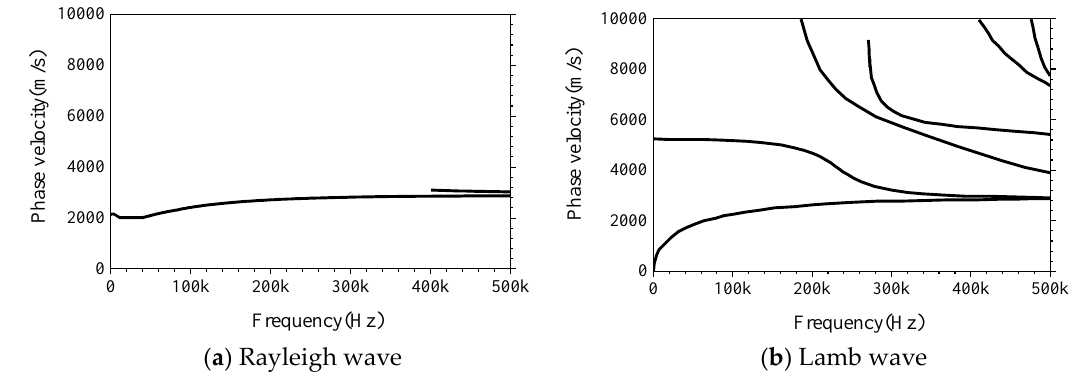
Figure 10. The theoretical dispersion curves of ( a ) Rayleigh and ( b ) Lamb waves.